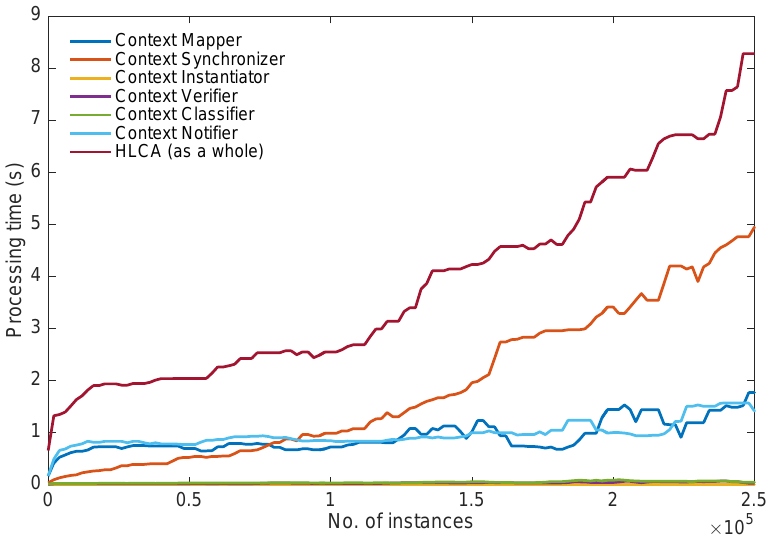
Figure 9. Processing time invested by each of the HLCA components in the context identification. The number of instances indicates the amount of previously processed high-level contexts when the recognition process is